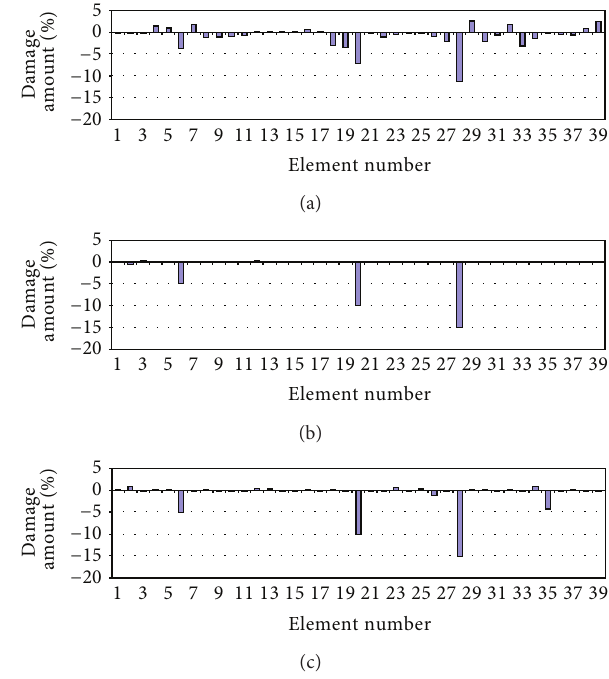
Figure 3: Inverse damage predictions for scenario 2 affected by the number of damaged-structure frequencies (NF), all original eigenvectors (NM) used, (a) 20 damaged-structure frequencies used, (b) 35 damaged-structure frequencies used, (c) 60 original eigenvectors (NM), and 35 damaged-structure frequencies (NF) used.